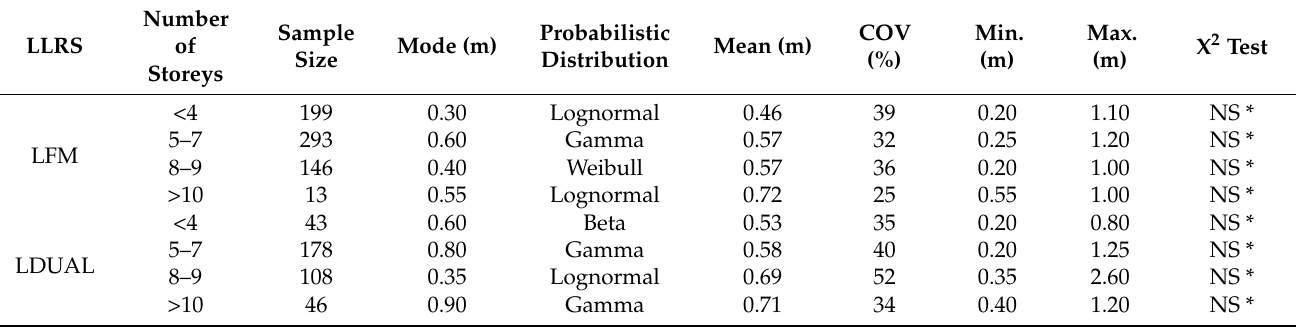
Table 7. Probabilistic distribution of RC columns (cid:48) depth in function of the lateral load resisting system (LLRS) and number of storeys.